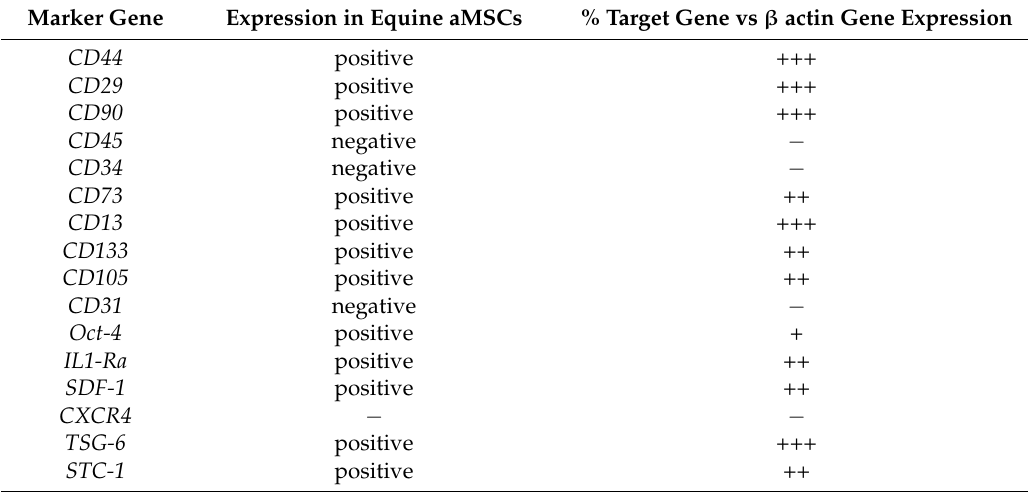
Table 1. Gene expression analysis of adipose tissue-derived mesenchymal stem cells (aMSCs) by means of semi-quantitative RT-PCR. Legend: − not expressed; + target gene expression <25% of β actin expression; ++ target gene expression 25–50% of β actin expression; +++ target gene expression >50% β actin expression. Results are the average of analysis of three different aMSC